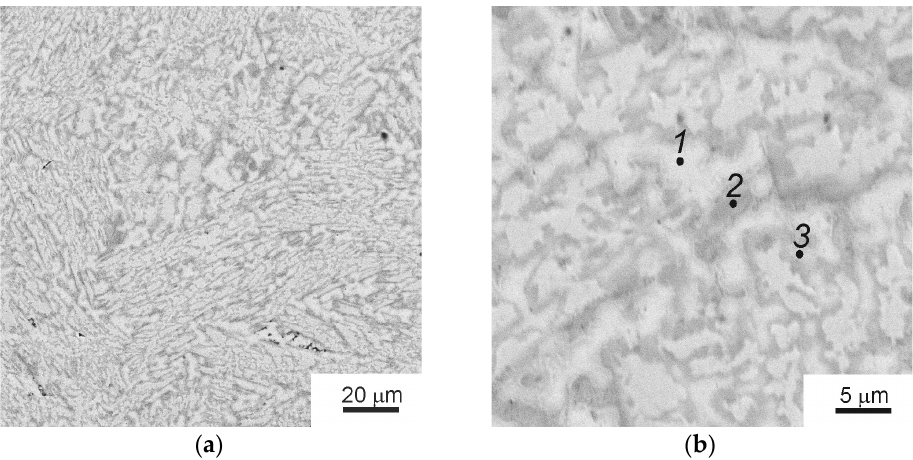
Figure 1. SEM micrographs of the as-cast TiZrHfMoCrCo alloy: ( a ) general view, ( b ) the component analysis areas are marked with dots: light gray ( 1 ), dark gray ( 2 ), and gray ( 3 ) areas.